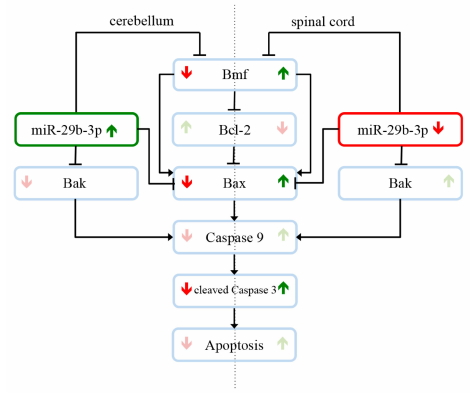
Figure 5. miR-29b-3p -mediated neuroprotection and neurodegeneration in the Wobbler mouse in the stable symptomatic phase (p40). Expression studies revealed that several members of the intrinsic apoptotic signaling cascade are expressed di ff erently in the cerebellum and spinal cord of wobbler mice compared to wildtype mice. Di ff erent regulations of the apoptotic mediators in the respective tissue correlate with di ff erent expression levels of miR-29b-3p . In the cerebellum of wobbler mice, miR-29b-3p is upregulated at p40 compared to wildtype mice. This overexpression downregulates in the following the proapoptotic factors BMF, Bax, and Bak, which leads to less apoptosis and thus neuroprotection. In the spinal cord, however, miR-29b-3p is downregulated so that there is not su ffi cient inhibition of the translation of proapoptotic factors, leading to apoptosis and thus neurodegeneration. These results suggest that miR-29b-3p regulates antiapoptotic survival mechanisms in CNS areas that are not a ff ected by